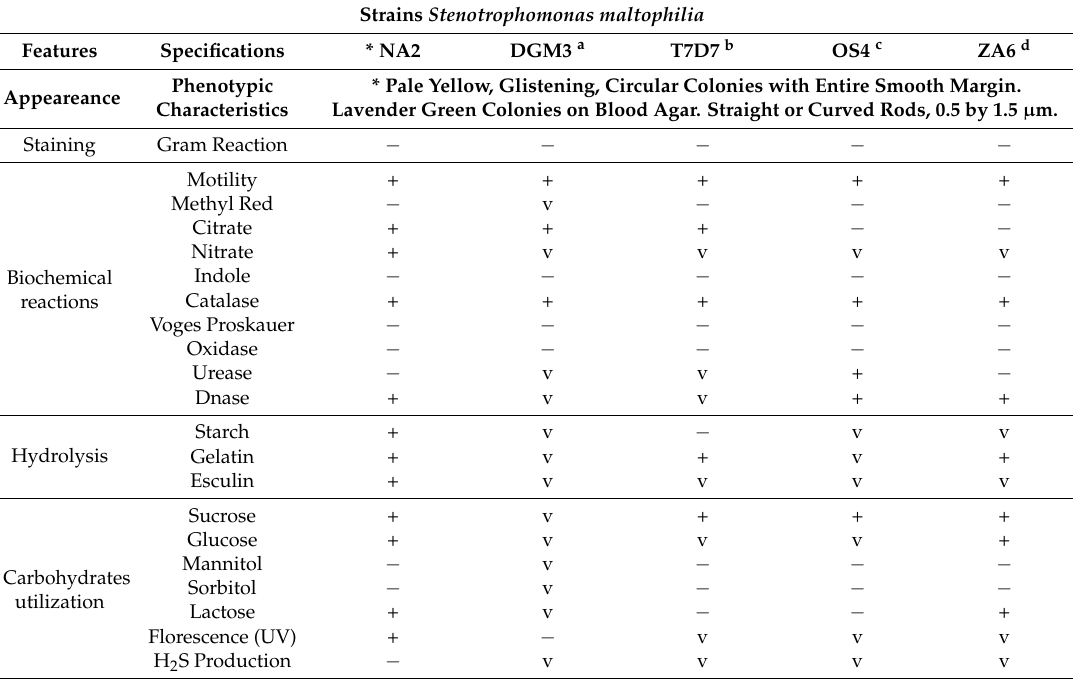
Table 1. Morphological and biochemical characteristics of Cr(VI) resistance